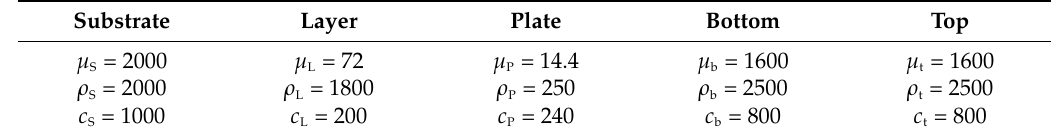
Figure 8. Magnified views of the two avoided crossings AC1 and AC2 from Figure 7 (Case 4). Table 1. Elastic material properties (in arbitrary units).